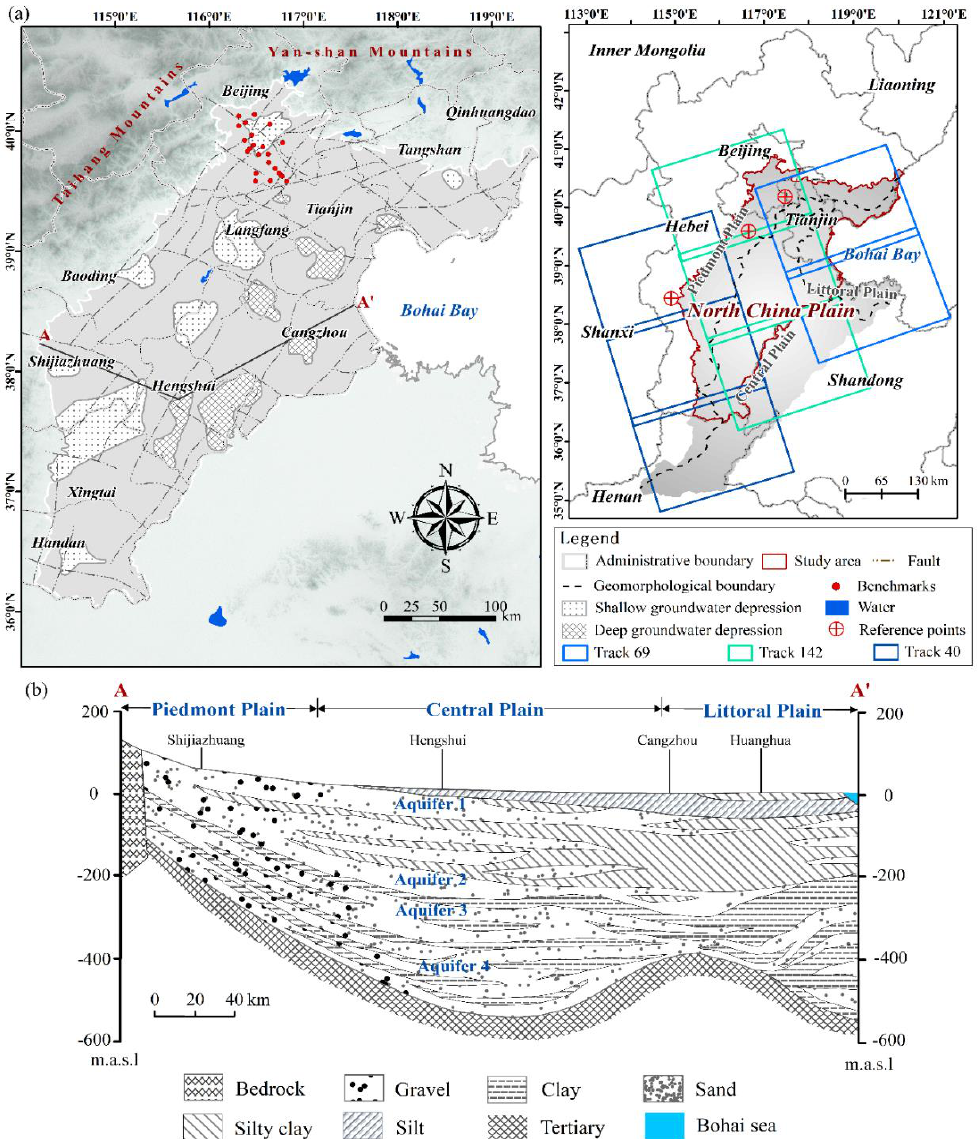
Figure 1. ( a ) Location of the study area and the coverage of the SAR datasets: the location of geological structures are derived from [41] and ( b ) the hydrogeological cross section A- A’ (revised after [34 – 36,38]).